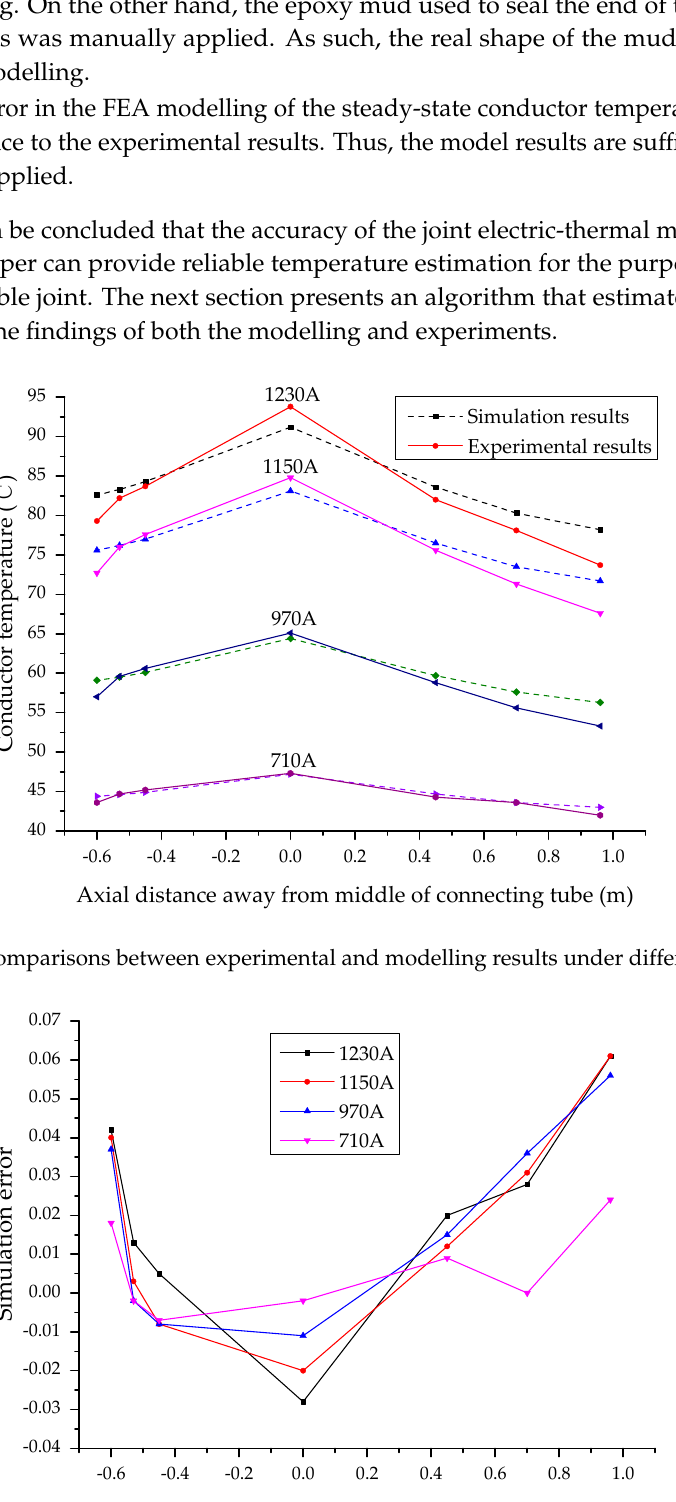
Figure 15. Modelling error analysis.